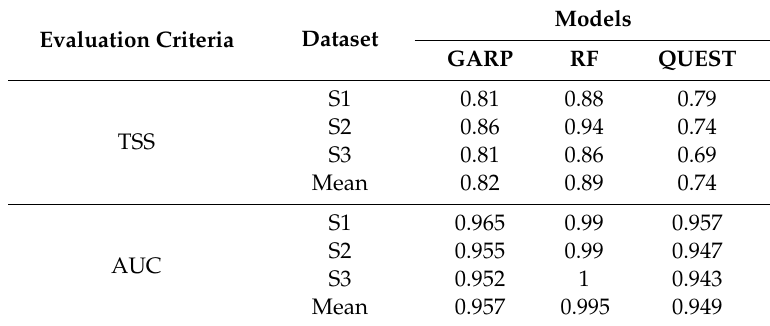
Table 4. Goodness-of-fit of the machine learning models based on di ff erent performance evaluation